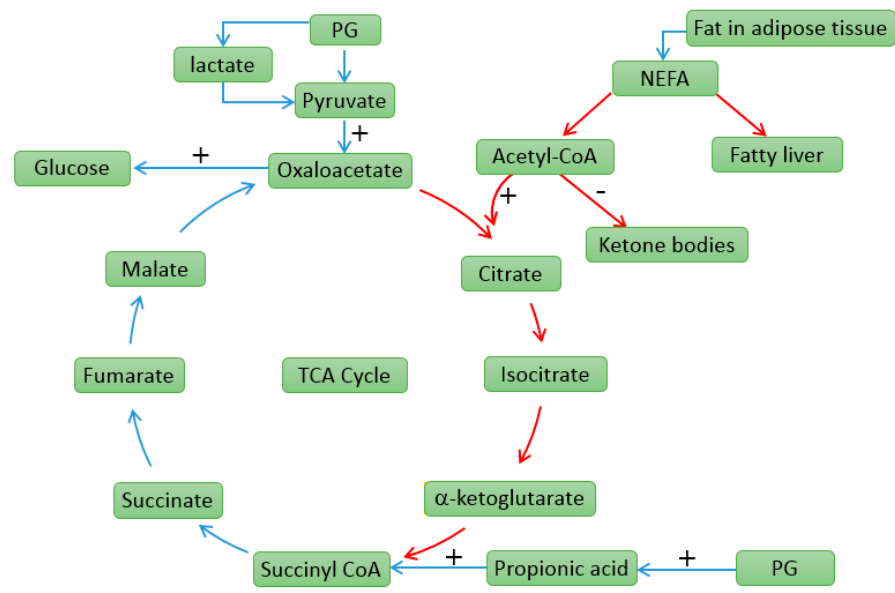
Figure 1. The anti-ketogenic pathways of propylene glycol (PG) in dairy cows [7]. The blue lines are to describe the gluconeogenic pathways of increasing the glucose to preventing ketosis. The red lines are the ways of increasing the oxidation of acetyl-CoA (coenzyme A) in the tricarboxylic acid cycle (TCA-cycle) and the supply of glucose by increasing the production of oxaloacetate, which will prevent acetyl-CoA convert to ketone bodies ( β -hydroxybutyrate, acetone, and acetoacetate). PG can also reduce the triacylglycerol (TG) accumulation in liver.